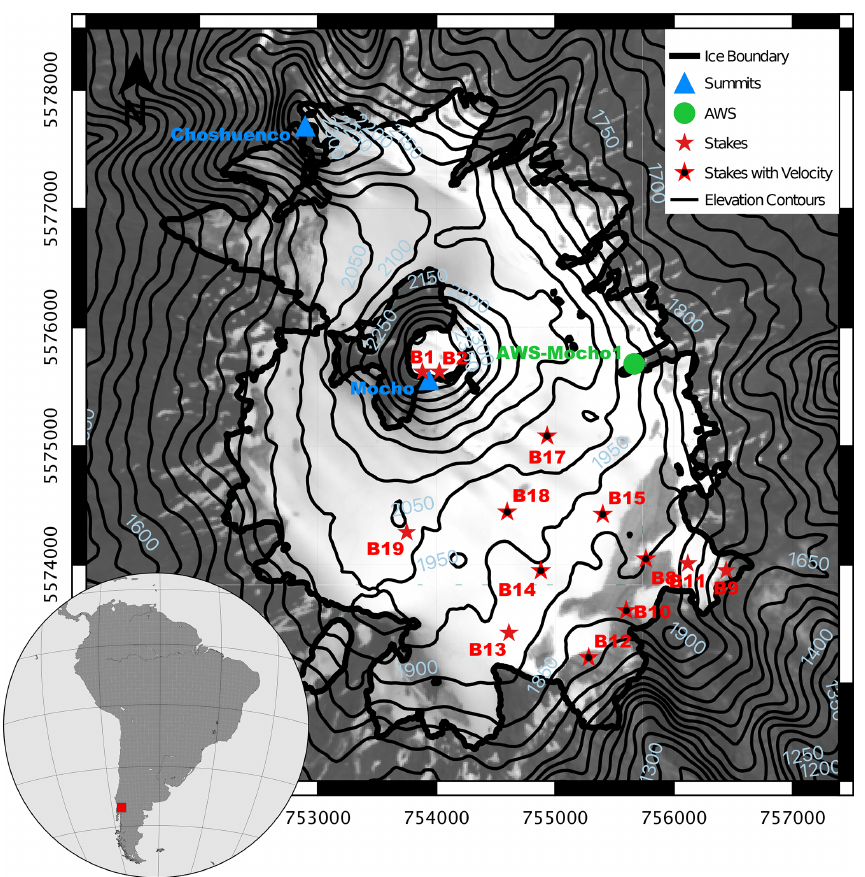
Figure 1. Overview map of the Mocho-Choshuenco ice cap with significant geographic features and measurement sites. The contour line spacing is 50m. East and north are in UTM S18. Background: Landsat image (22 February 2015). Inset map shows location in South